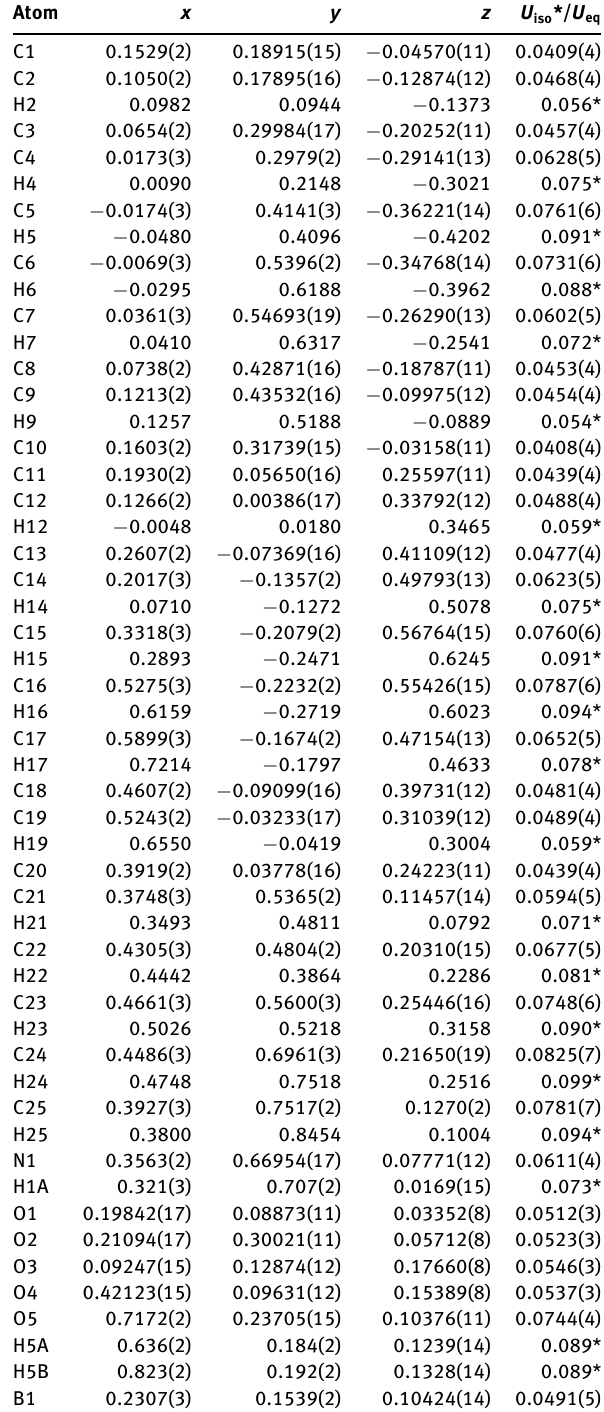
Table 2: Fractional atomic coordinates and isotropic or equivalent isotropic displacement parameters (Å 2